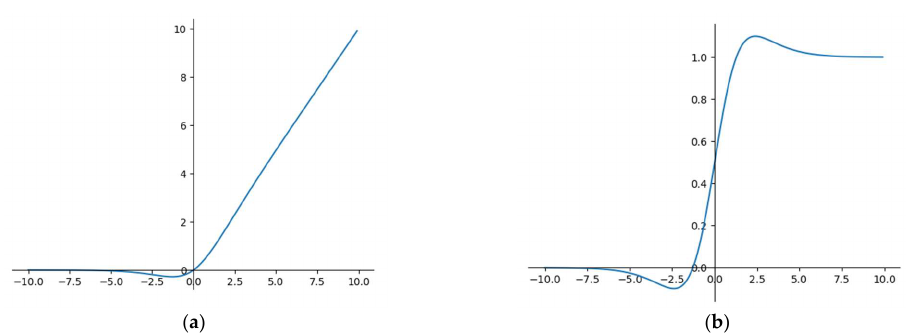
Figure 6. The graph of SiLU: ( a ) is the SiLU function graph; ( b ) is the derivative SiLU function graph.